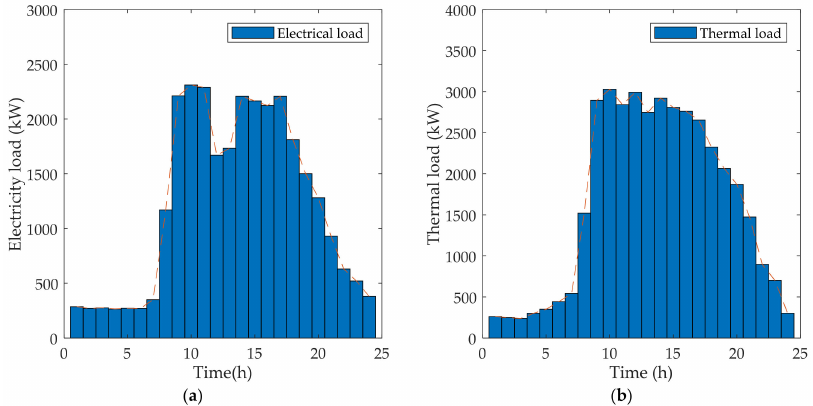
Figure 8. Energy consumption load in Case 1: ( a ) electrical load, ( b ) thermal